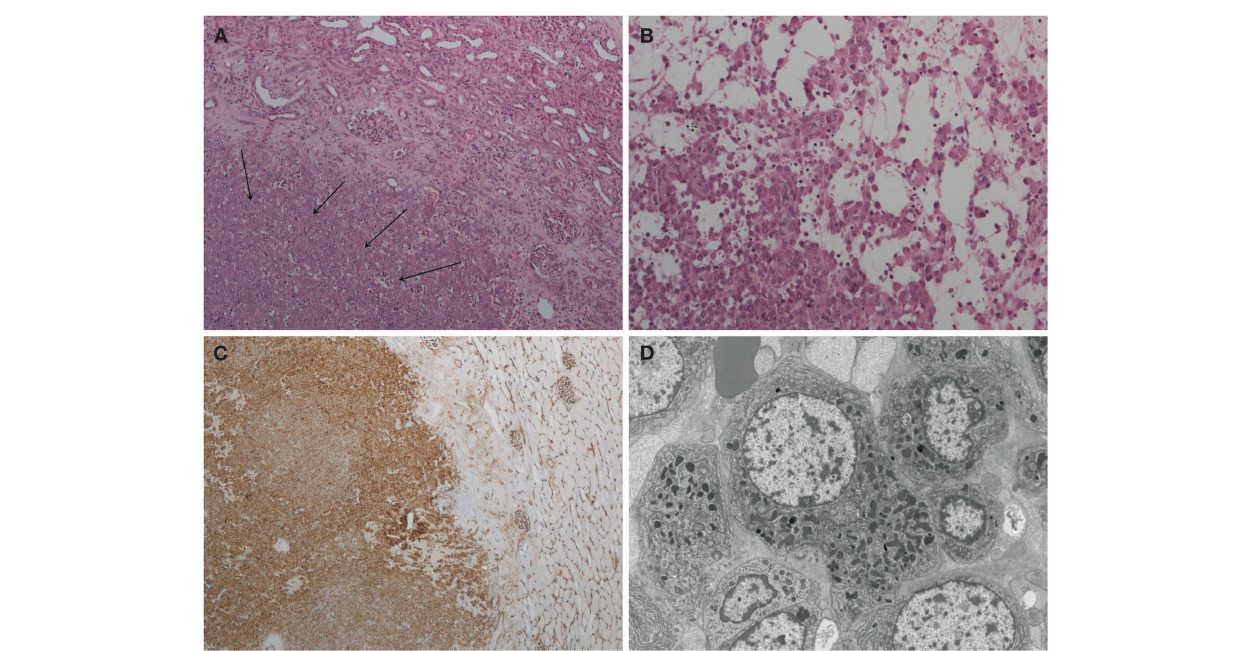
solid with edema and single cells. (C) CD34 immunoperoxidase stain, × 40 magnification.The tumor cells stain positive for CD34. Adjacent glomerular vasculature acts as an internal positive control. (D) Electron microscopy.The tumor cells are characterized by uniform non-enlarged nuclei and a cytoplasm shows numerous pleiomorphic (rounded, polygonal, and rhomboidal) dense deposits, consistent with renin